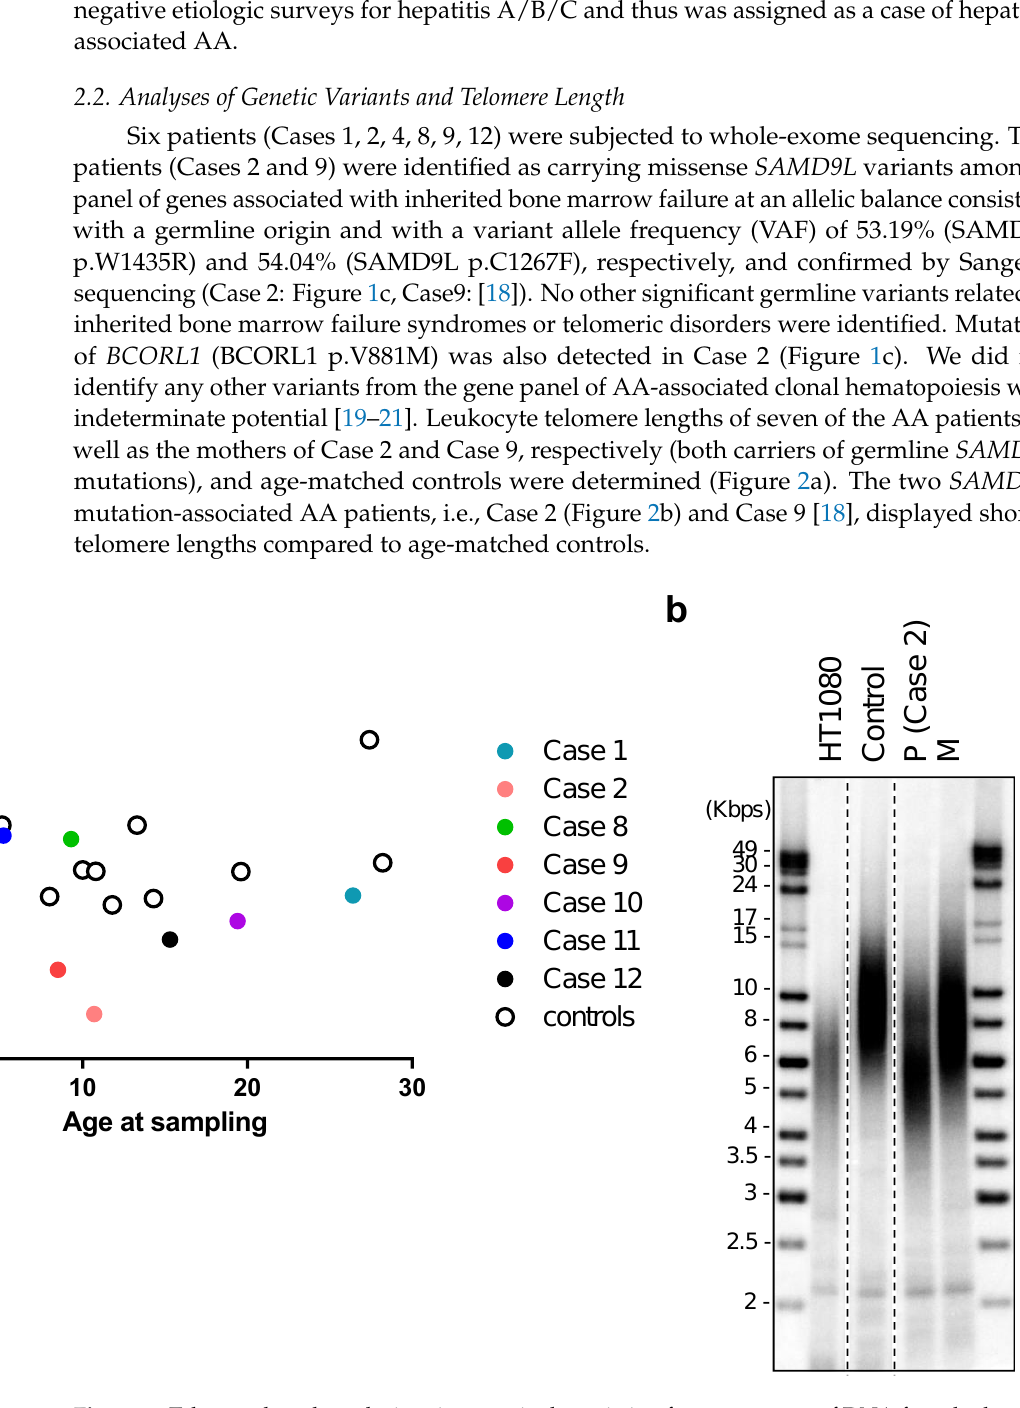
Figure 2. Telomere length analysis using terminal restriction fragment assay of DNA from leukocytes of: ( a ) Cases 1, 2, 8 – 12 in this cohort and age-matched controls (no diagnosis of AA); and ( b ) Case 2 patient (P) at diagnosis of aplastic anemia (age: 10.7 years old), Case 2′ s mother (M, age: 48 years old), a healthy control of similar age to the patient (10.8 years old), and from HT1080 fibrosarcoma cancer cells. DNA samples were run in the same gel, which has been cropped for illustrative purposes.